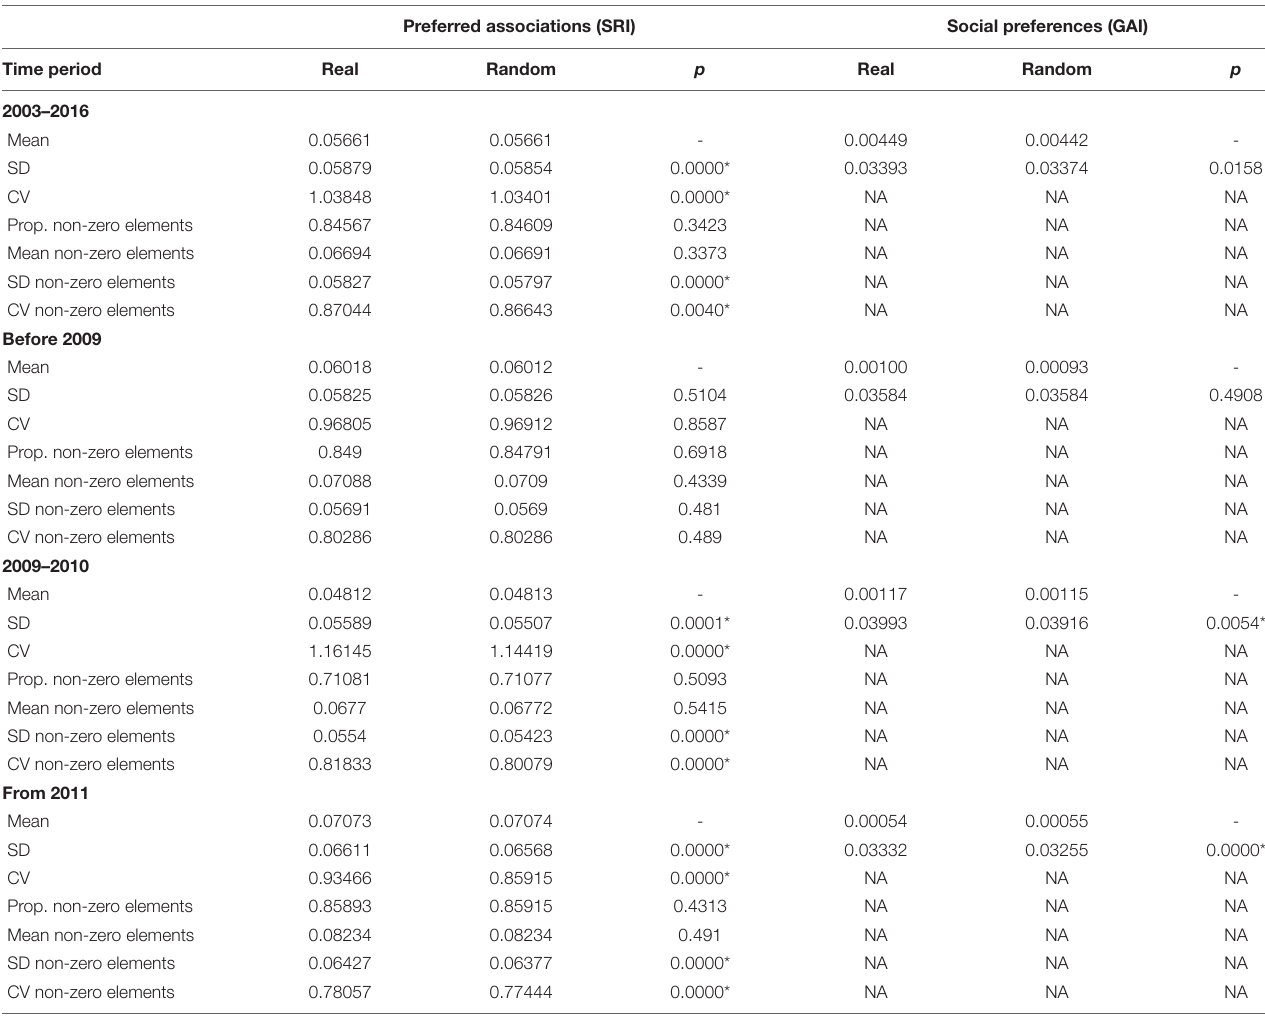
TABLE 3 | Tests for preferred and avoided associations of bull sharks. Preferred associations (SRI) Social preferences